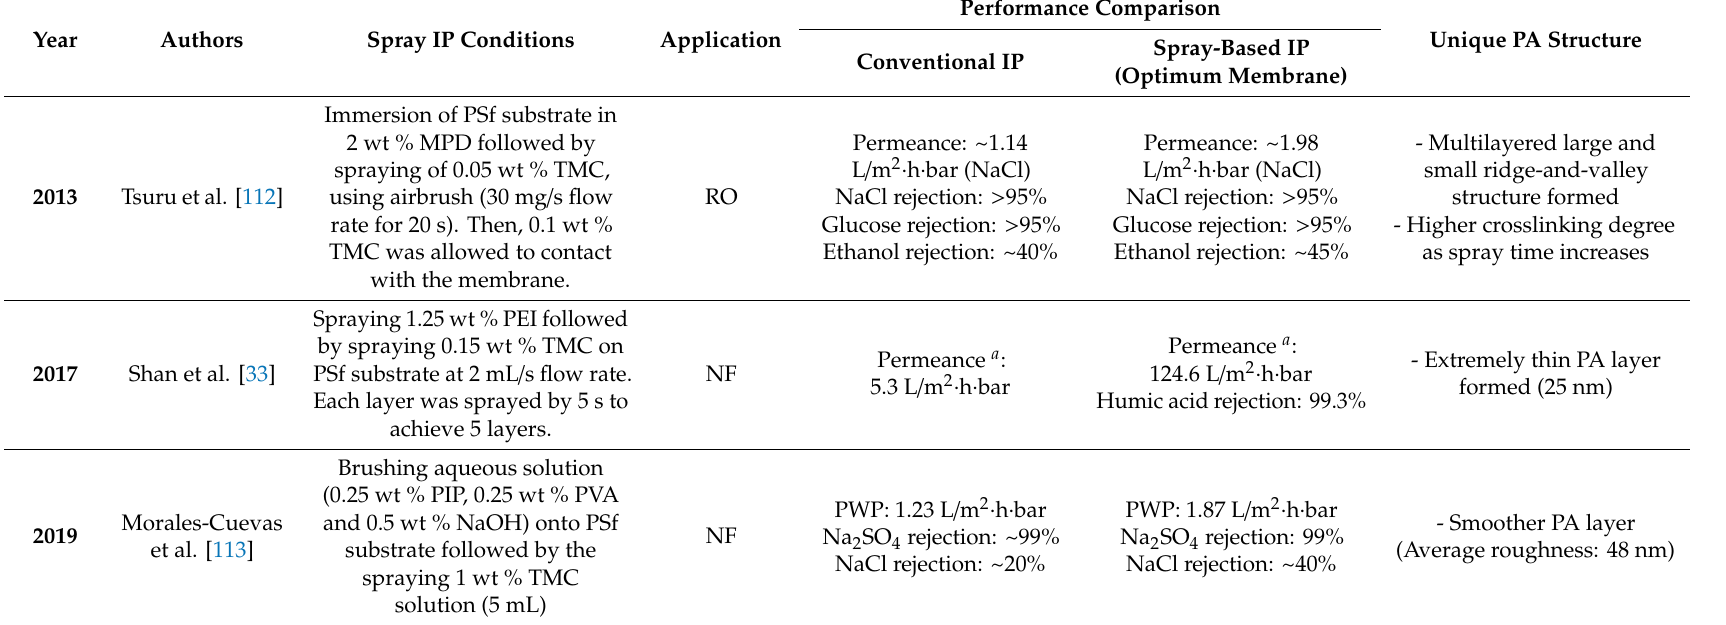
Table 5. Comparison of TFC membranes fabricated by using conventional and spray-based